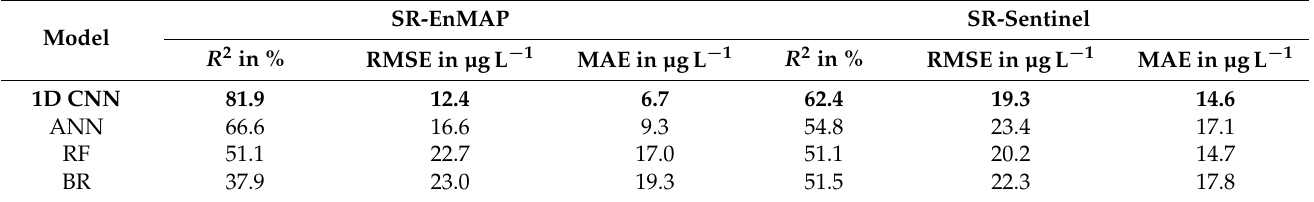
Figure 9. Visualization of the models’ estimation results based on the RMSE-scores on the different water bodies with the two different downsampled resolutions. Table 4. Results for the chlorophyll a estimation of all SpecWa inland water